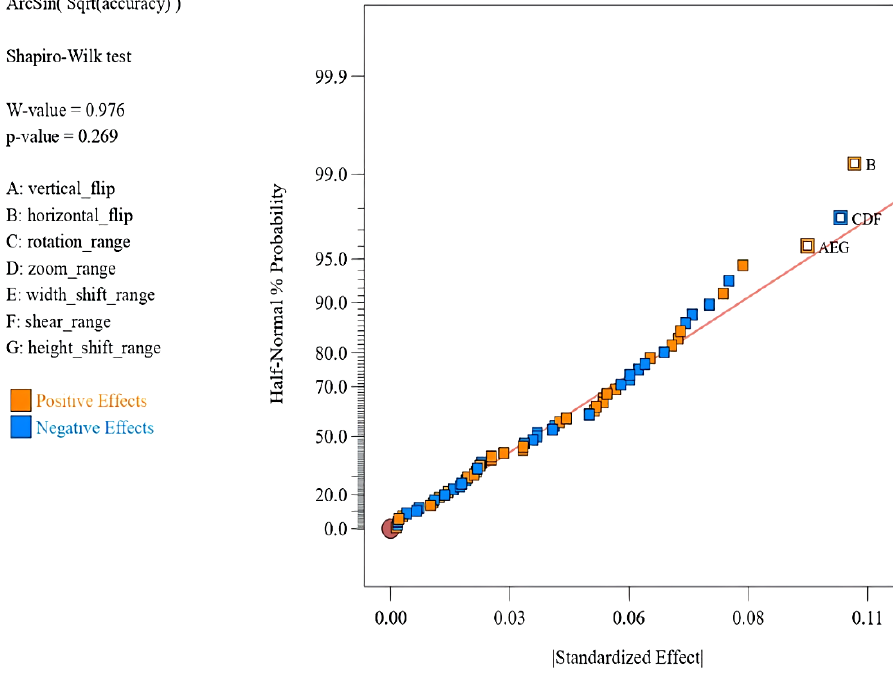
Figure 7. Half Normal Plot for Dataset